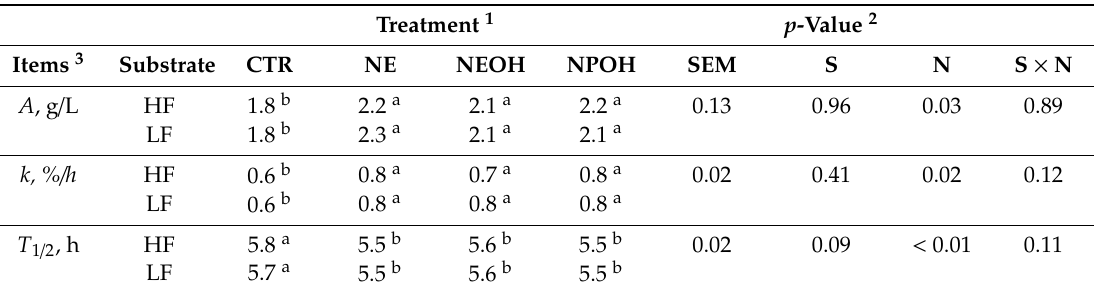
Table 6. The accumulation kinetics of bacterial crude protein (BCP) during in vitro ruminal fermentation of substrates with a high (HF) and low (LF) forage content incubated in batch cultures of mixed rumen